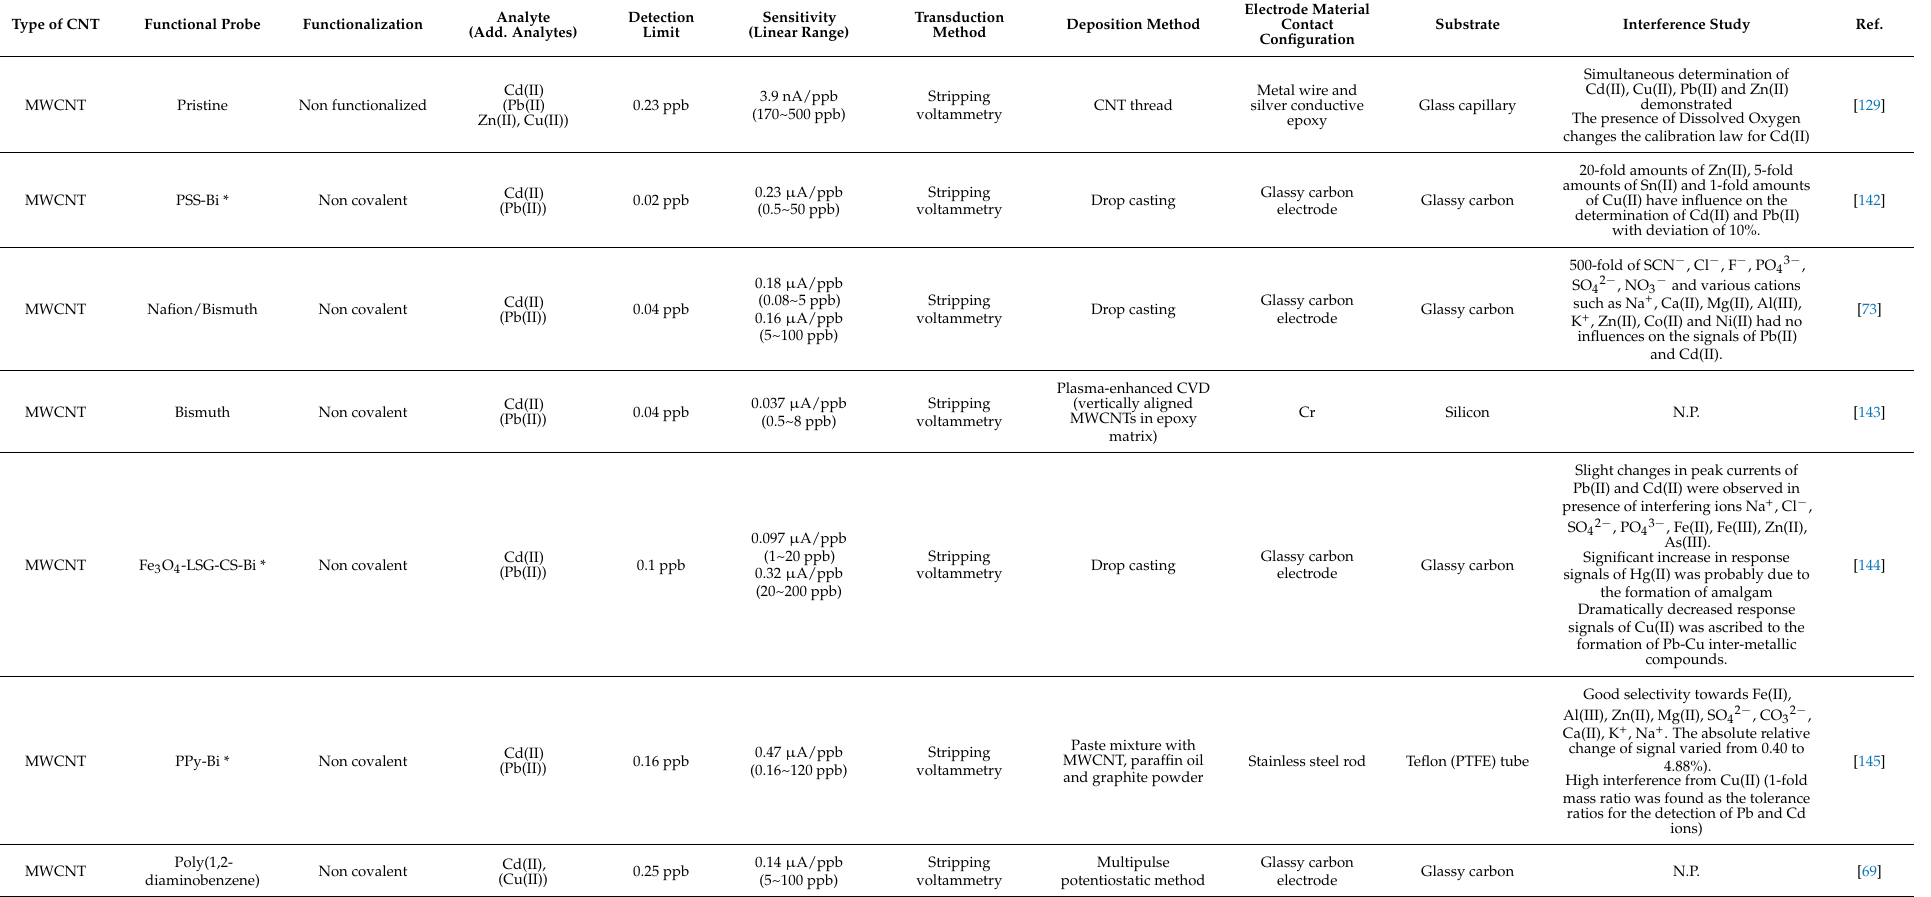
Table 4. CNT-based sensors for detecting Cd(II) ions in water, sorted by type of functionalization then by detection